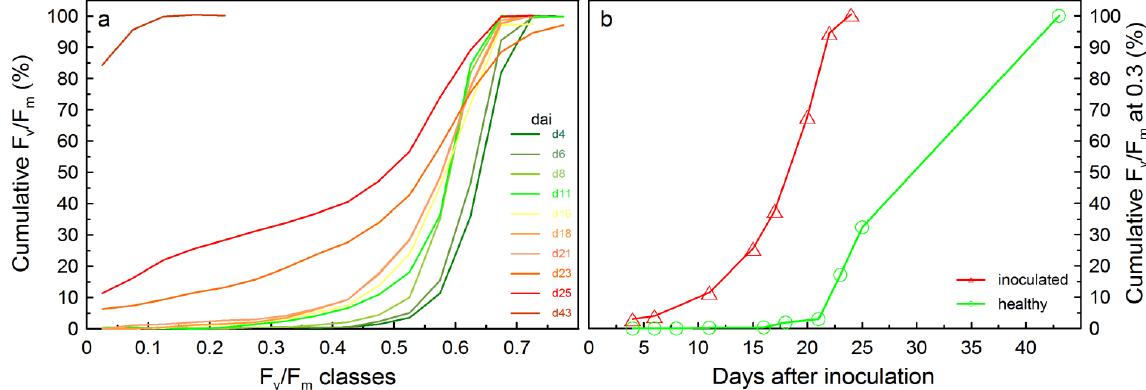
Figure 2. ( a ) Relative cumulative F